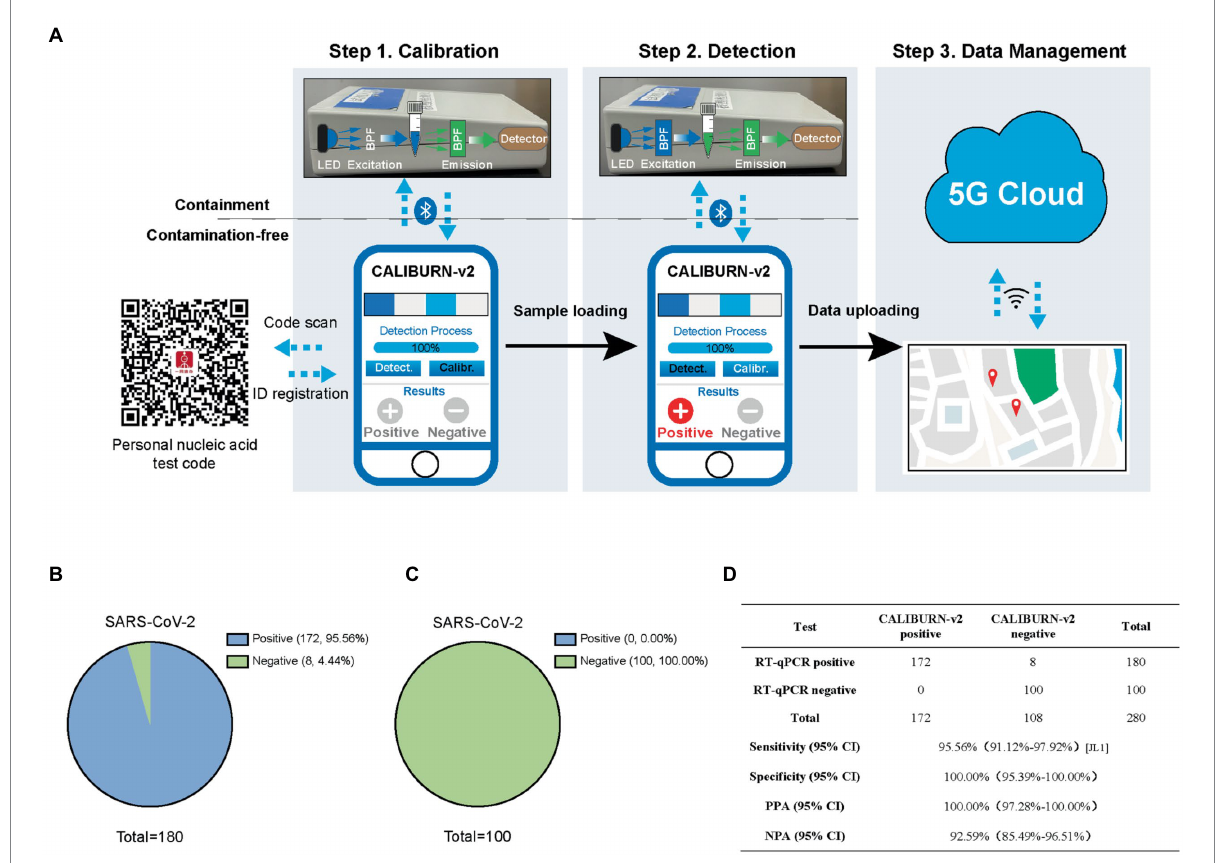
FIGURE 3 Integration of smartphone-controlled POCT with the closed-lid, CALIBURN-v2. (A) Schematic illustration of smartphone-controlled signal readout using the POCT device. The detection results are sent to the 5G cloud for subsequent analysis. The red dots denote the locations of positive cases in the map. (B) Sensitivity of CALIBURN-v2 on viral nucleic acid from clinical specimens. (C) Specificity of CALIBURN-v2. The RT-RPA primers and crRNAs for SARS-CoV-2 are used to detect nucleic acid samples from healthy donors, respectively. (D) Concordance between RT-qPCR and CALIBURN-v2 for SARS-CoV-2 detection. PPA, positive predictive agreement; NPA, negative predictive agreement; CI, confidence